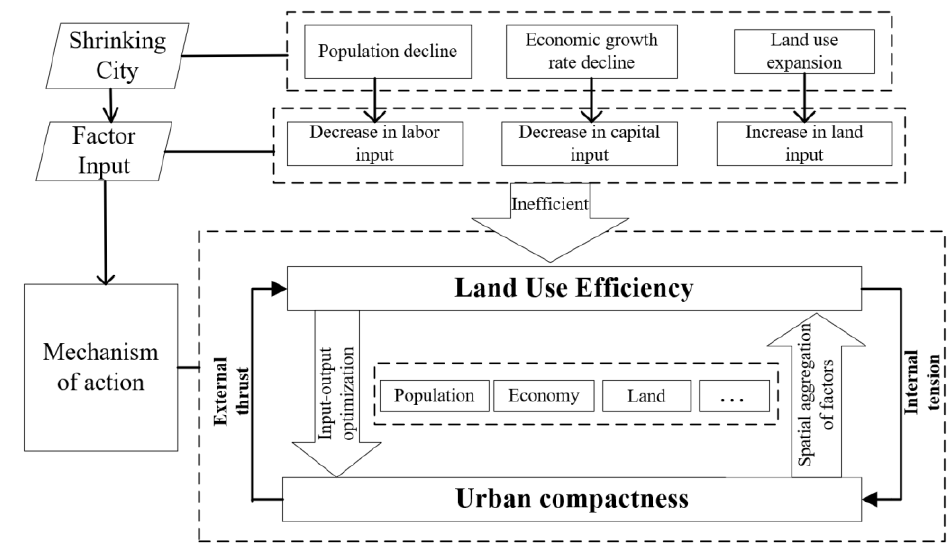
Figure 1. The coordination model of compactness and land-use efficiency in shrinking cities. (Source: Authors).